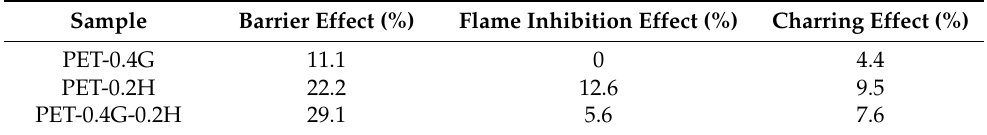
Table 5. Quantitative comparison of flame-retardant modes for PET